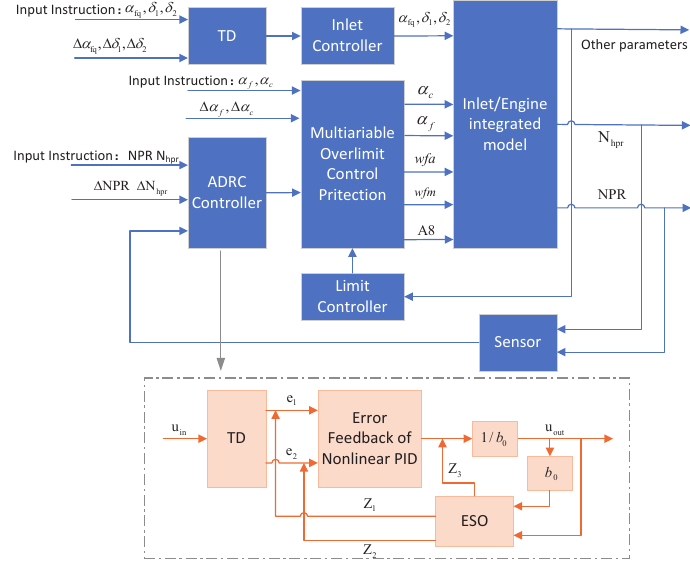
Figure 4. Schematic diagram of the engine’s ADRC control